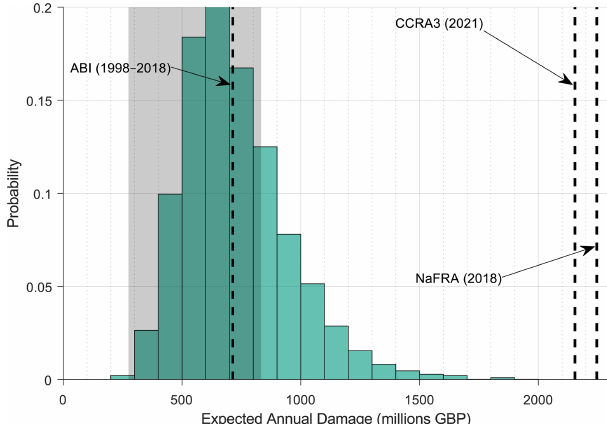
Figure 4. Simulated expected annual damage from 10000 random samples of 20-year time periods for the model developed in this paper, for 2020 conditions compared to adjusted values from pre- vious model estimates from the Environment Agency’s National Flood Risk Analysis (NaFRA), the UK’s Third Climate Change Risk Assessment (CCRA3) and observations from the Association of British Insurers (ABI). The grey shading denotes the interquartile range of the ABI